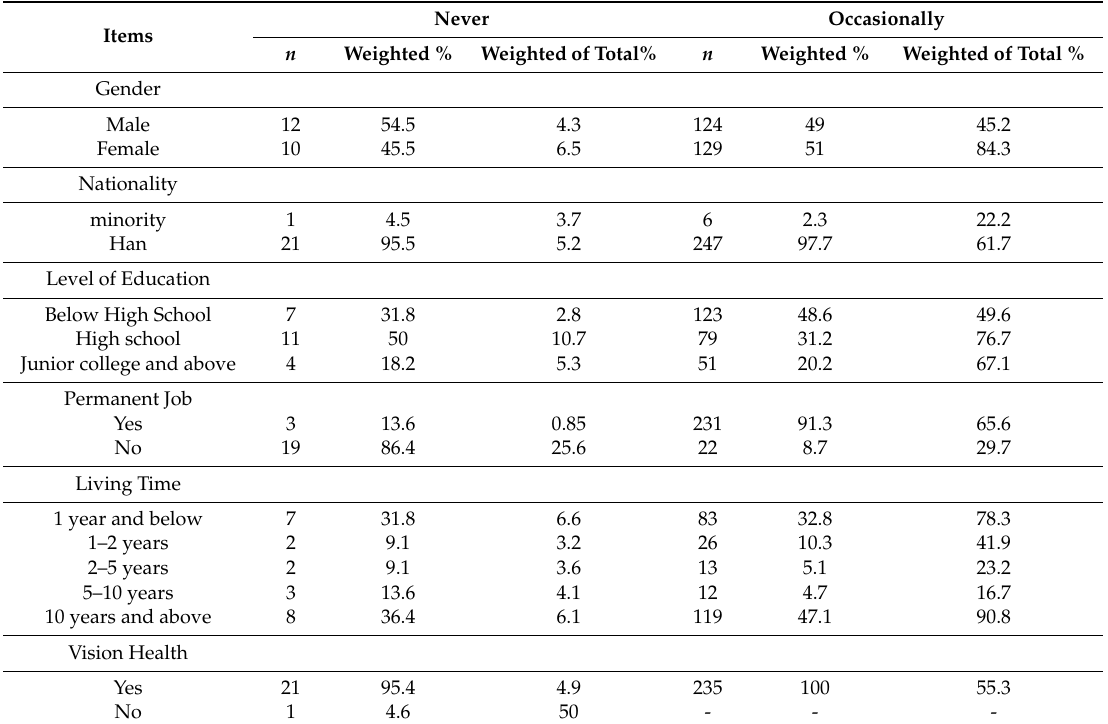
Table 6. Social profile of those who frequently visited the blue space ( n = 152), those who had never visited the blue space ( n = 22), and those who visited occasionally ( n = 253).